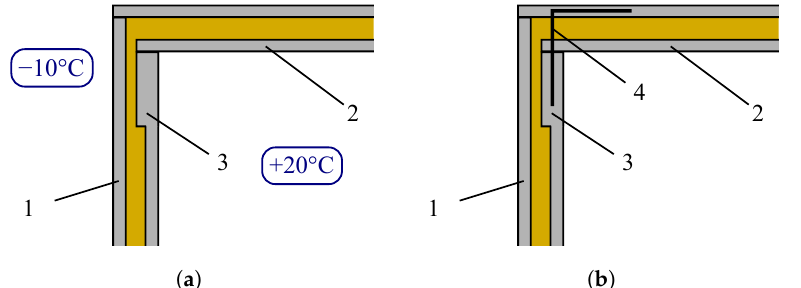
Figure 1. Details of the top of the wall: ( a ) without a connector and ( b ) with a connector between the wall and slab; 1—insulated wall panel, 2—insulated roof slab, 3—increased thickness of inner wythe, 4—steel connector.